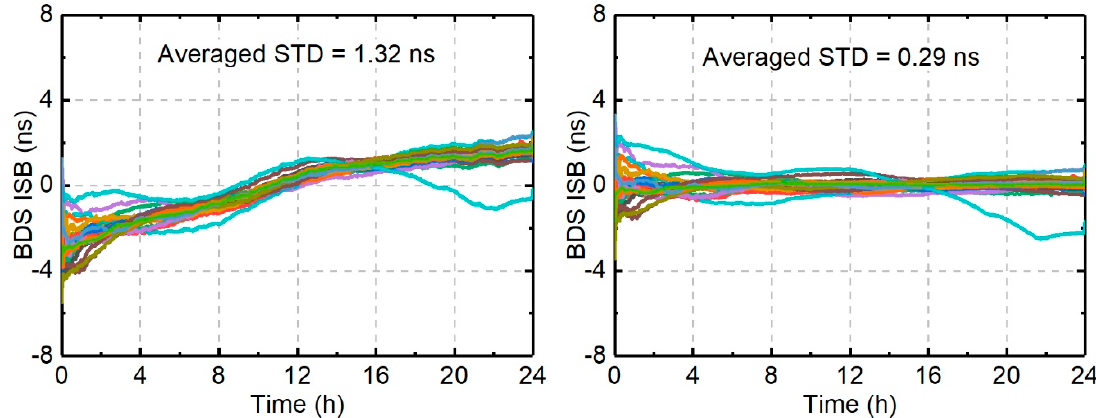
Figure 3. One day (3 September 2019) ISB series for BDS-2, first with the mean removed (left panel), and then, with both the mean and the common trend term removed (right panel).